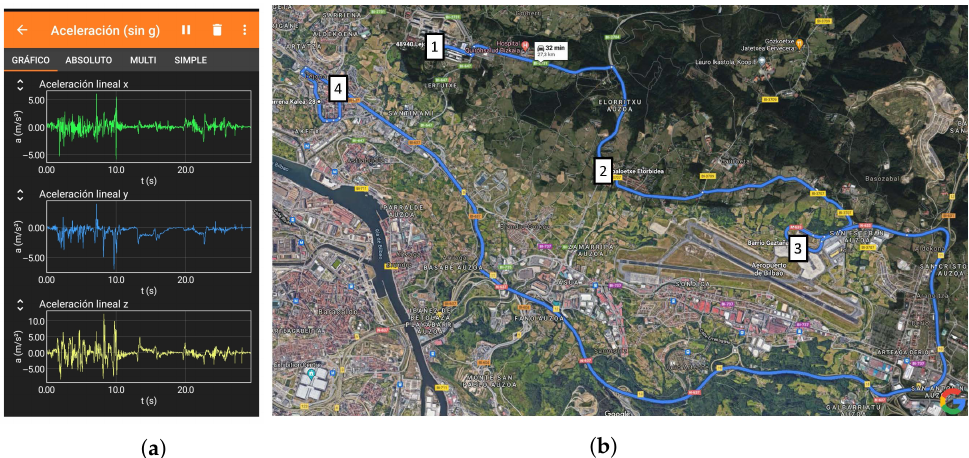
Figure 2. Selected data acquisition device and journey. ( a ) An example of a screenshot during data acquisition [53]; ( b ) selected 26-km journey near Bilbao, in the north of